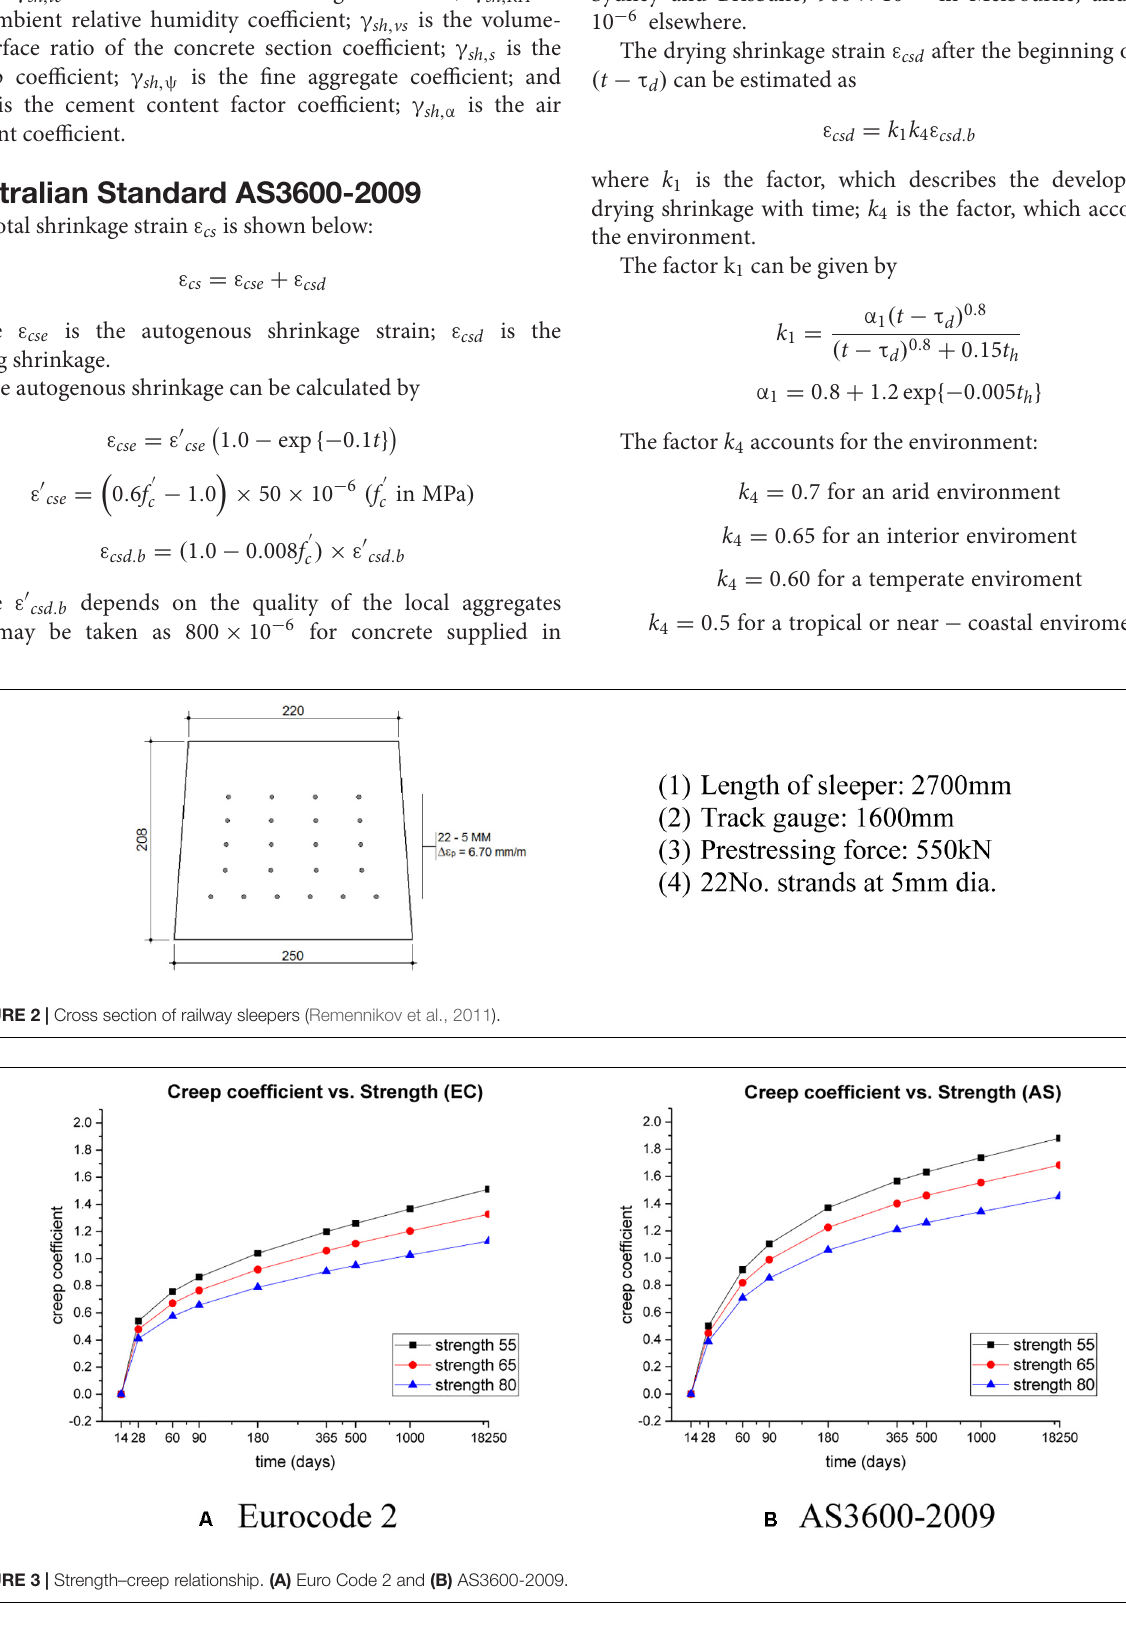
Frontiers in Built Environment |